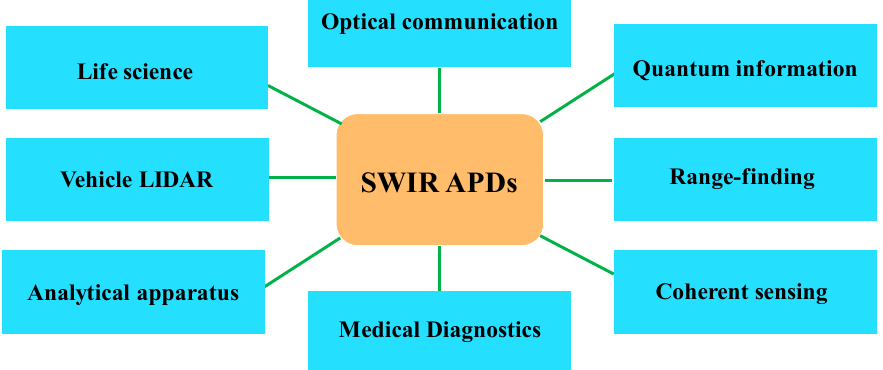
Figure 1. Potential applications of SWIR APDs in various fields.